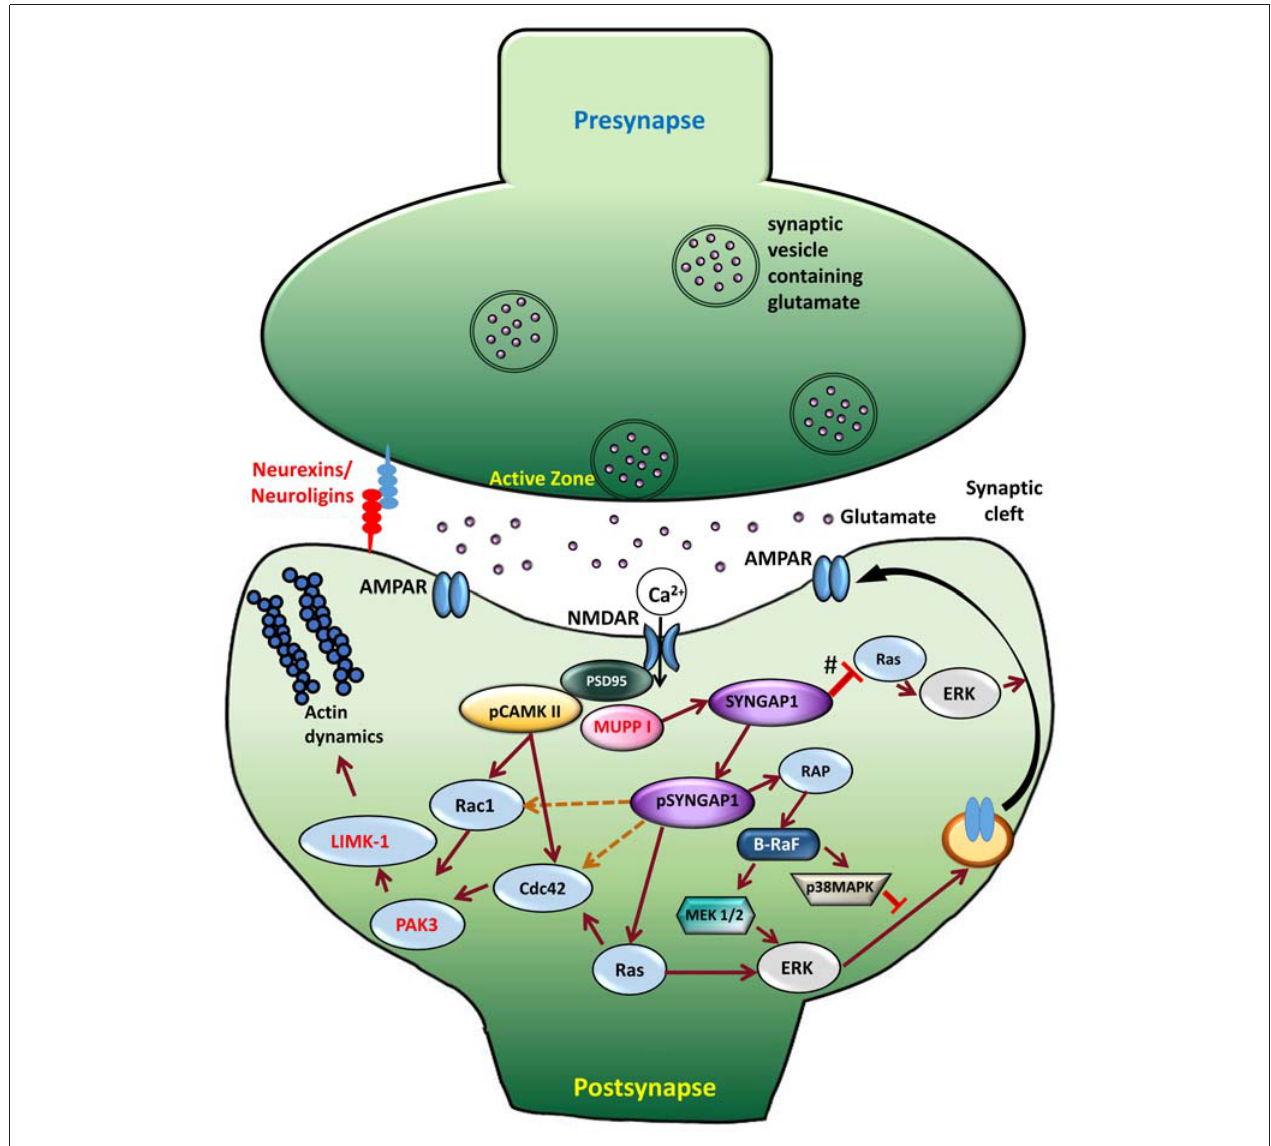
FIGURE 3 | Signaling mechanism upon phosphorylation of SYNGAP1 . Schematic model of the cellular events that link CaMKII activity to phosphorylation of SYNGAP1 and its regulation of downstream molecules. Glutamate receptors, such as NMDAR and AMPAR, are clustered at the postsynaptic active zone with a dense matrix called PSD. Upon NMDAR activation, Ca 2 + enters the postsynaptic cytosol, triggering phosphorylation of CaMKII, which in turn phosphorylates SYNGAP1 (pSYNGAP1). pSYNGAP1 regulates Ras-GTPases controlling actin dynamics and AMPARs insertion into the postsynaptic membrane. In Syngap1 Heterozygous mutation, the inhibition of Ras activation by SYNGAP1 (shown as #) is lost, which increases Ras activity, thereby increasing AMPAR exocytosis to the postsynaptic membrane. Phosphorylation of SYNGAP1 by cyclin-dependent kinase 5 (CDK5) activates Rap1 that increases endocytosis of AMPAR. It is not clear how pSYNGAP1 regulates other SYNGAP1-associated proteins such as Cdc42, Rac1 (dotted orange lines), which are yet to be